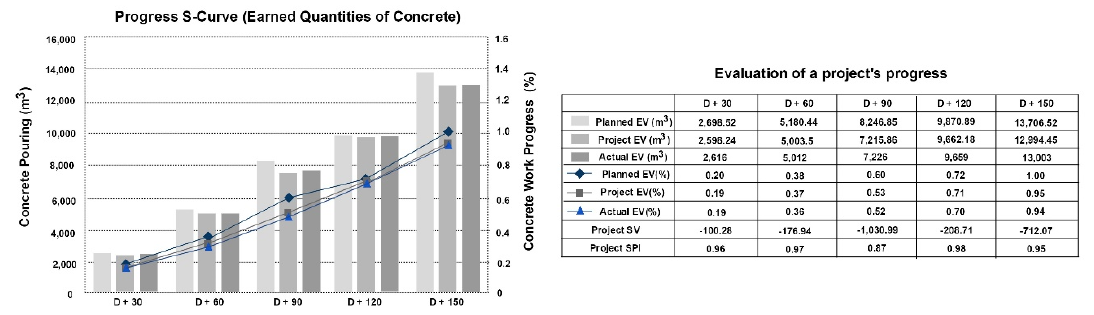
Figure 9. Project progress evaluation of the case study site.